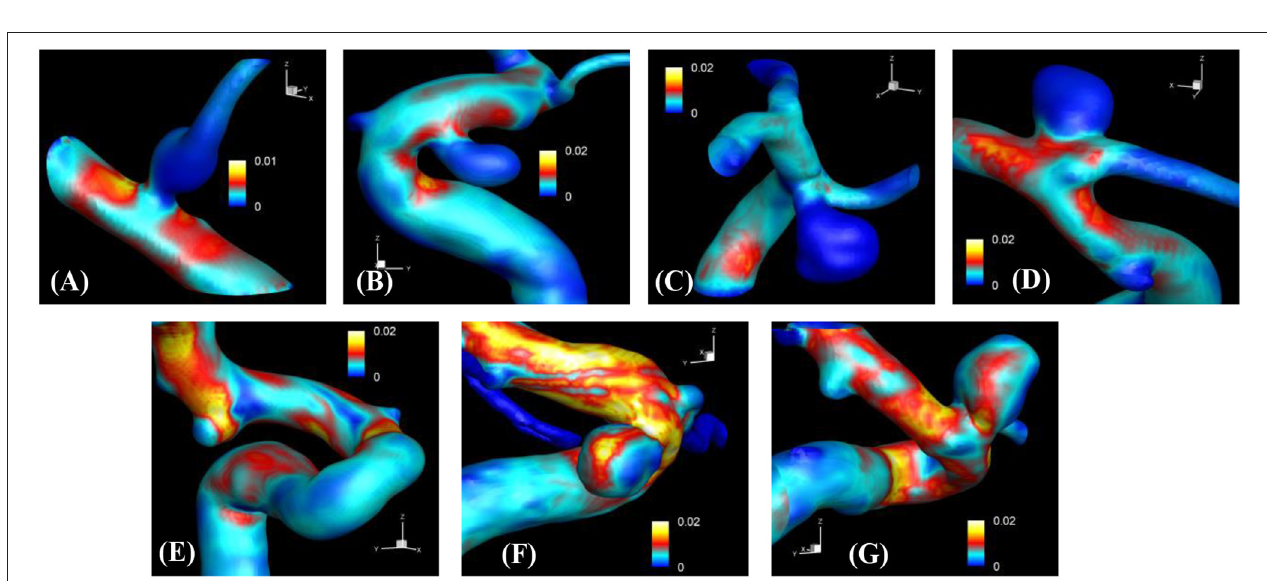
FIGURE 10 | The results of automated hemodynamic simulations using the present immersed boundary, level-set method for the sample cases (A–G) . Iso-surfaces of φ = 0 are plotted and colored by the calculated magnitude of wall shear stress (unit in kPa). The color contours are truncated at the range shown in the color bar for the best visualization of local